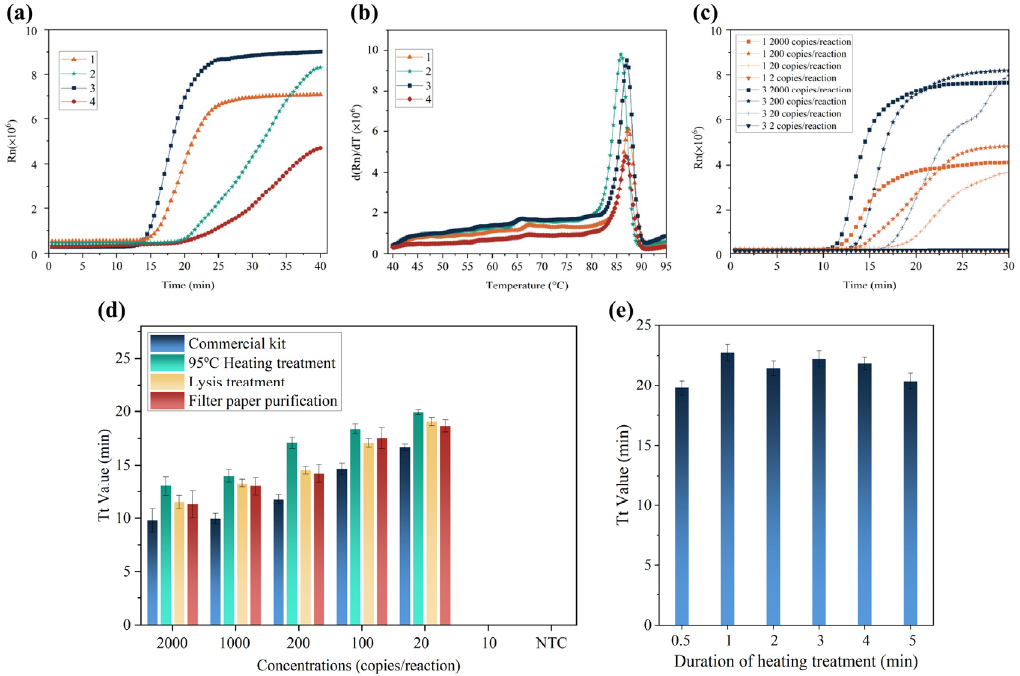
Figure 1. ( a ) RT-LAMP amplification curves of four different primer sets. ( b ) Amplicon melting curves of the primer sets. Numbers 1 and 2 represented the primer set designed by our group; 3 and 4 represent the primer set from the work of Huang et al. ( c ) Comparison of detection sensitivity for the two primer sets with the better amplification performance. The orange curves represent the primer set designed by our group; the dark blue curves represent the primer set from the work of Huang et al. ( d ) Comparison of three sample treatment methods for spiked frozen shrimp samples with different concentrations of SARS-CoV-2. ( e ) Influence of different heating times for RT-LAMP reaction with spiked shrimp samples.